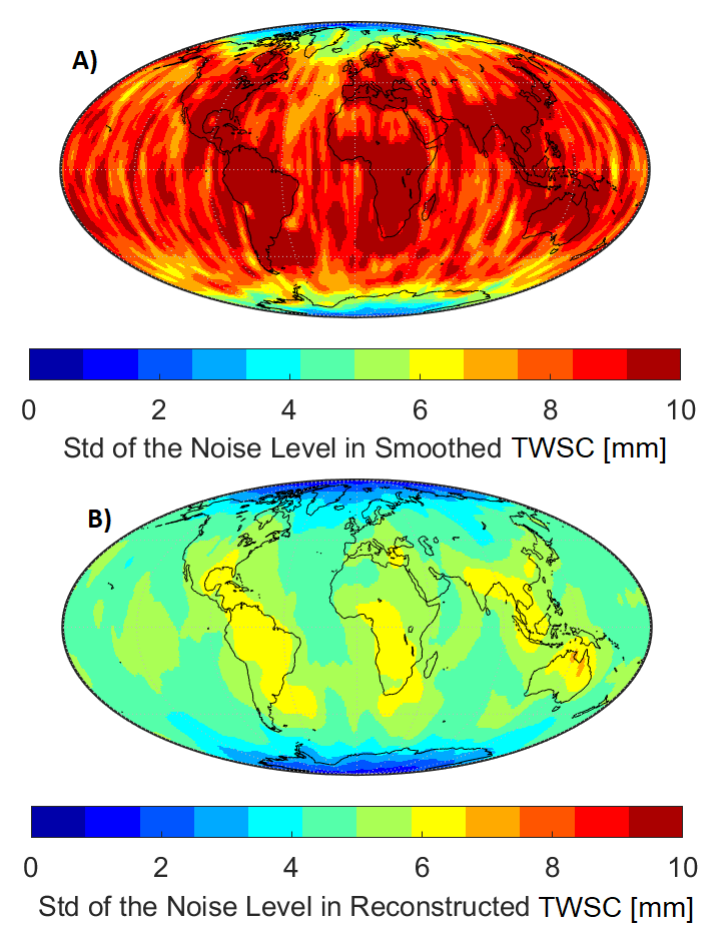
Figure A3. A comparison between the noise level of TWSC fields before ( A : left) and after reconstruction ( B :